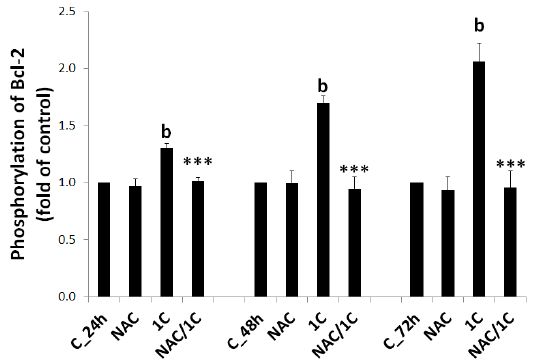
Figure 9. Relative levels of phosphorylated bcl-2 after 24, 48, and 72 h of 1C or NAC/1C treatment. Significantly different b p < 0.01 vs. untreated cells (control); *** p < 0.001 vs. 1C.